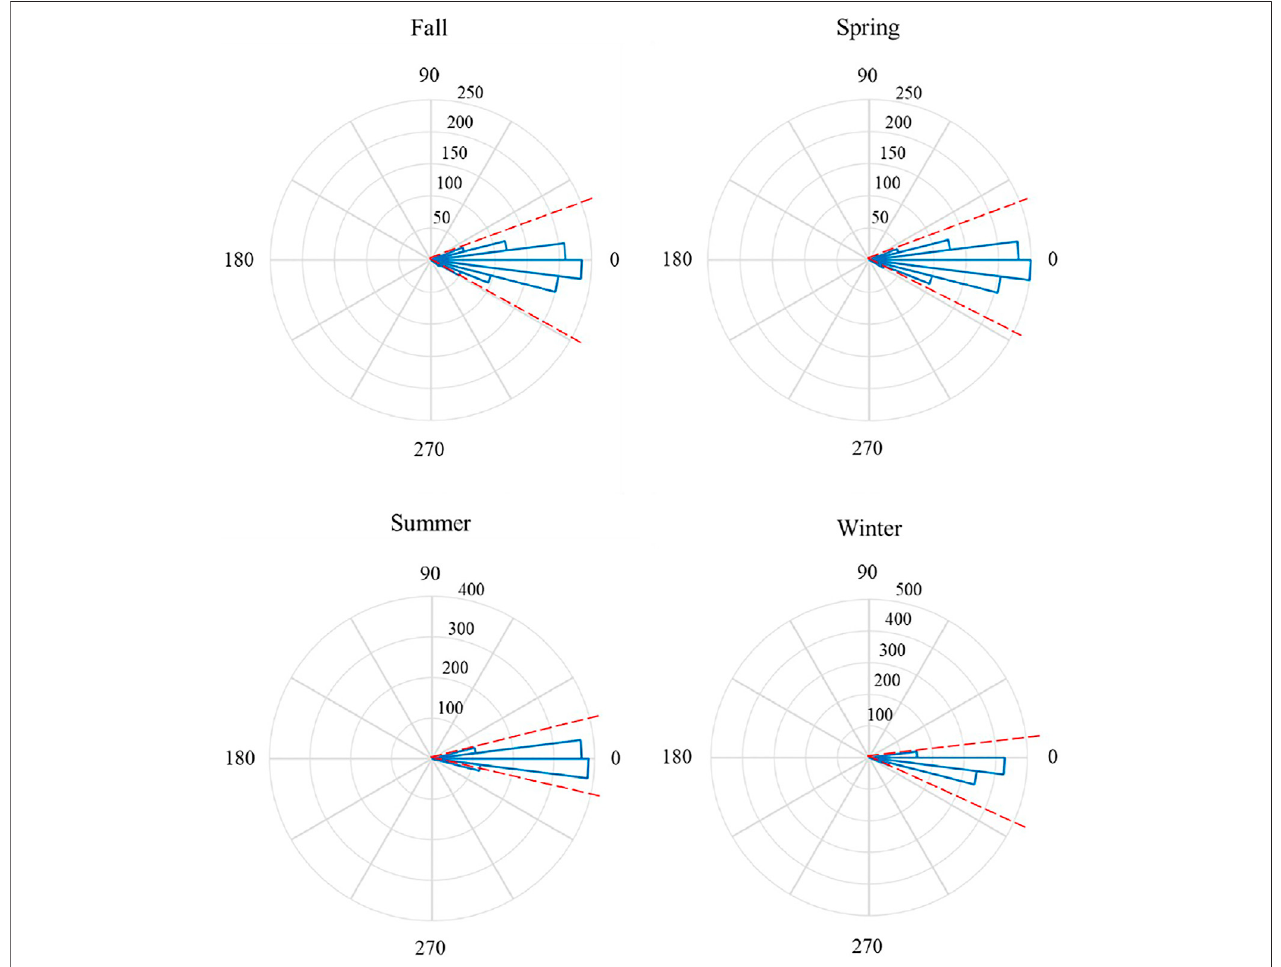
FIGURE 9 | Wind rose of the prediction errors for the four seasons of interest in 2020.